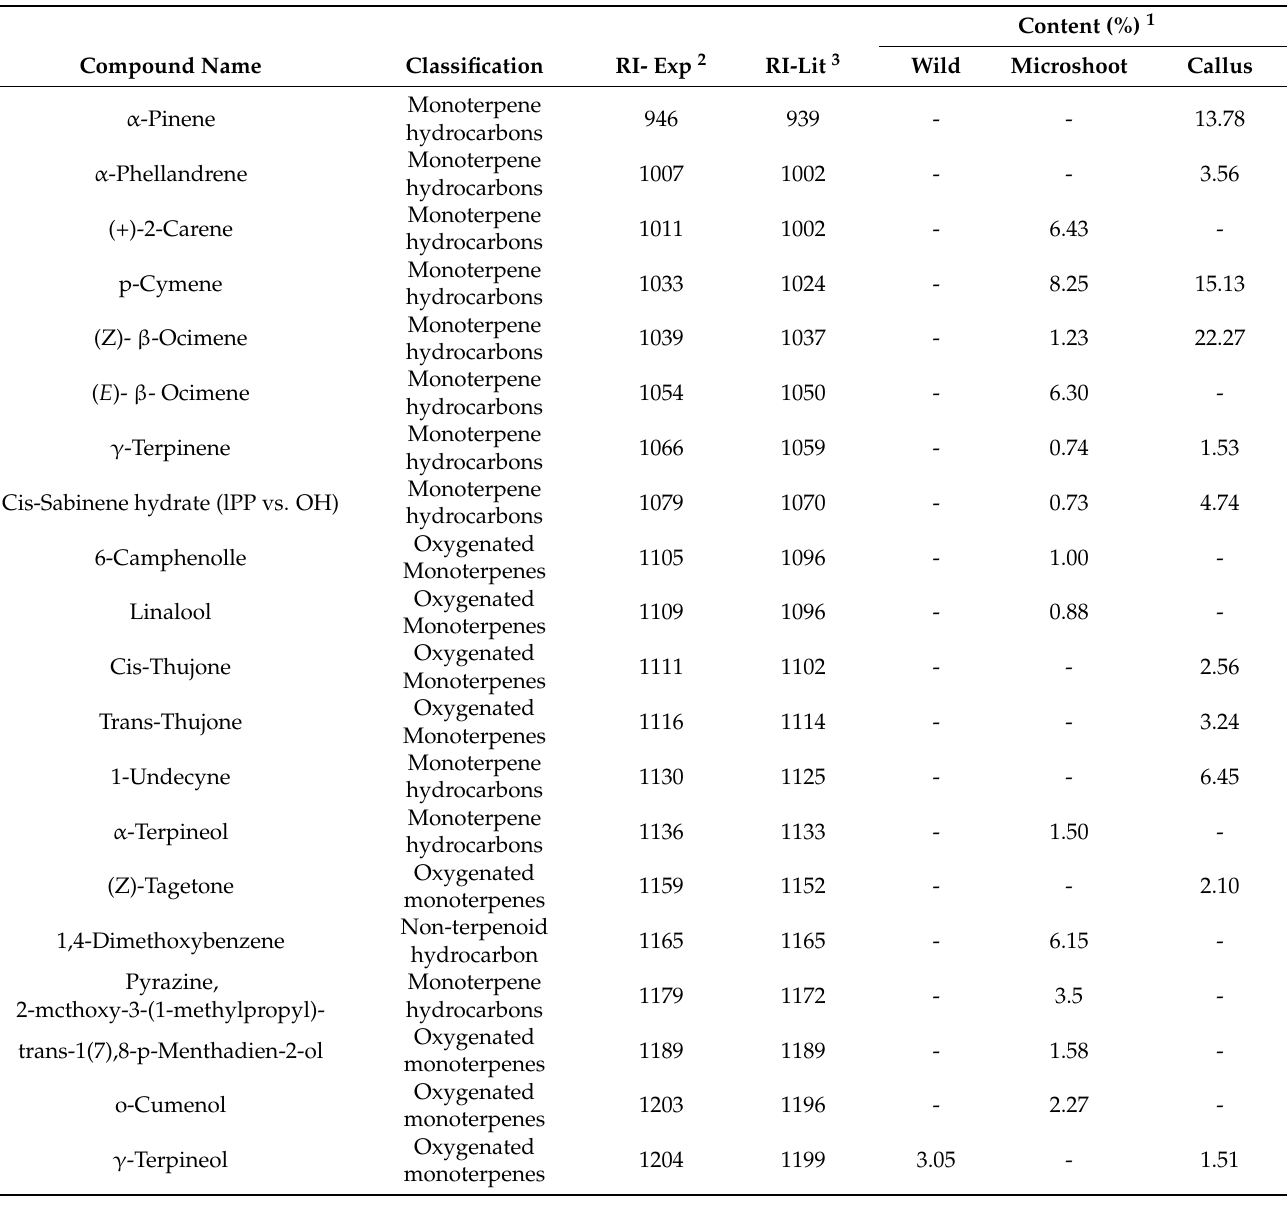
Table 4. Volatile organic compounds (VOCs) identified in different sample extracts of C. montanus and their